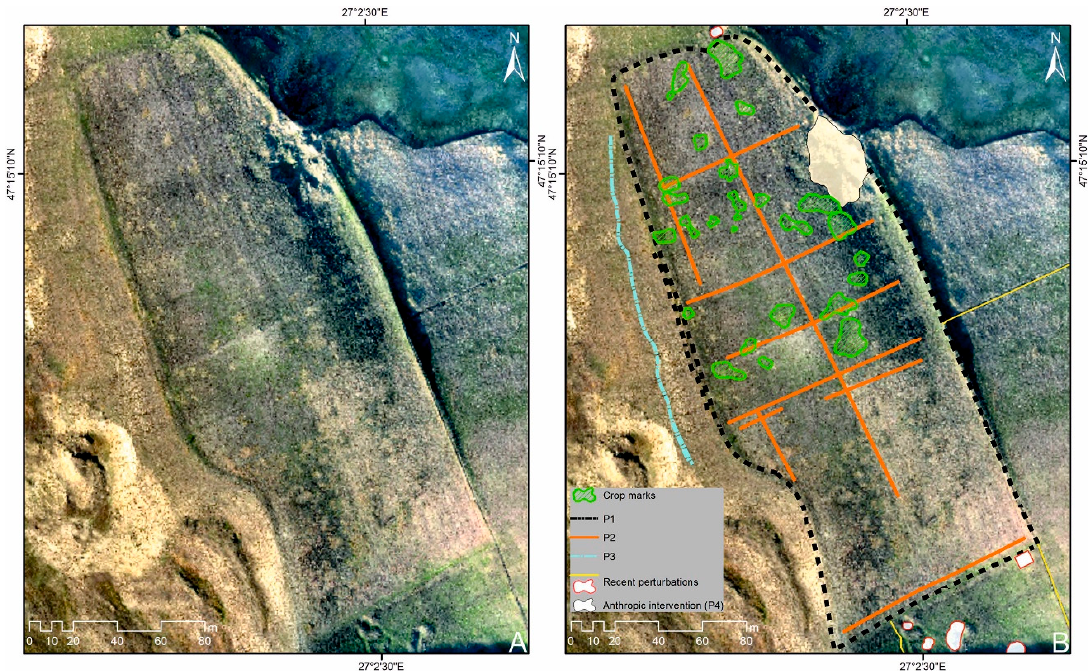
Figure 9. Identifying anomalies in air photographs: ( A ) Orthorectified air photograph; ( B ) Features of possible cultural interest.